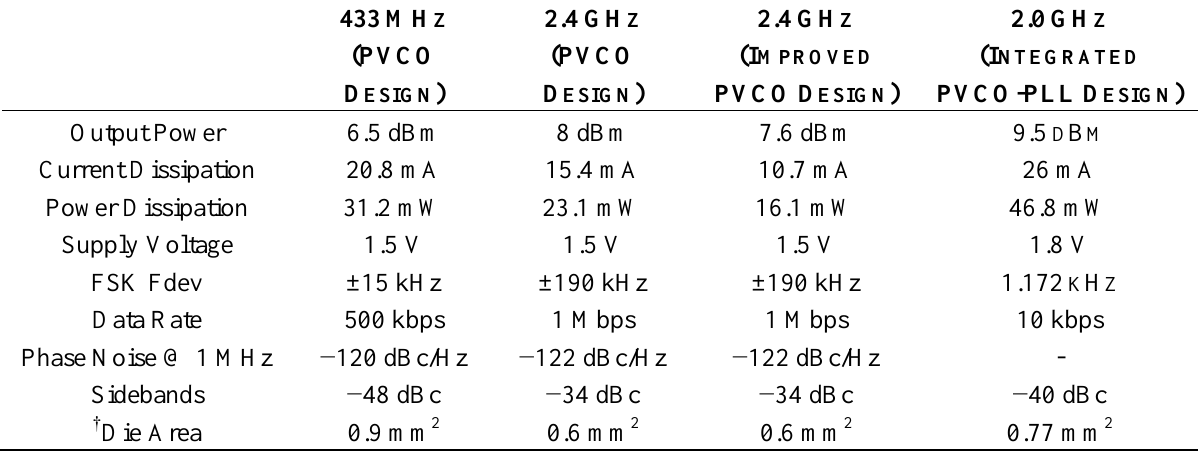
Table 2. Performance evaluation of direct-modulation RF